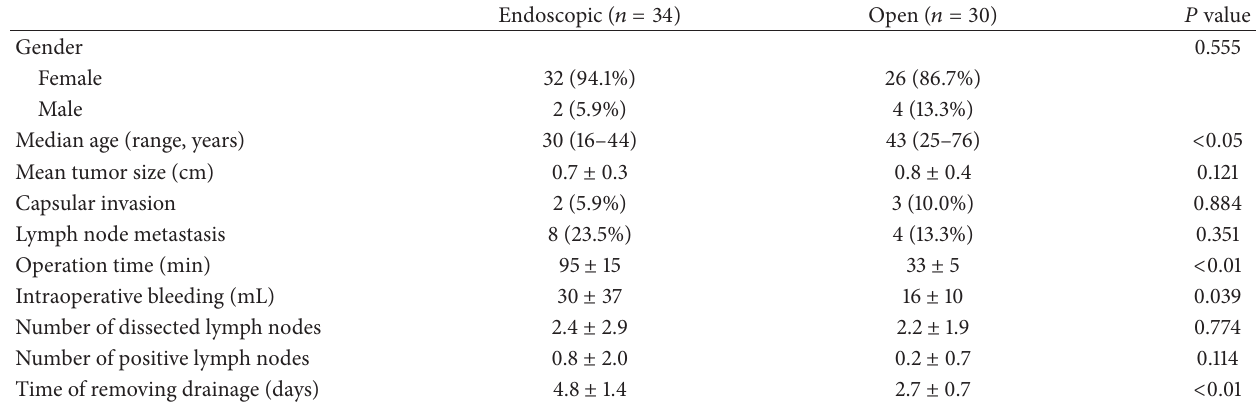
Table 1: Comparison of clinical characteristics of the patients in two groups.